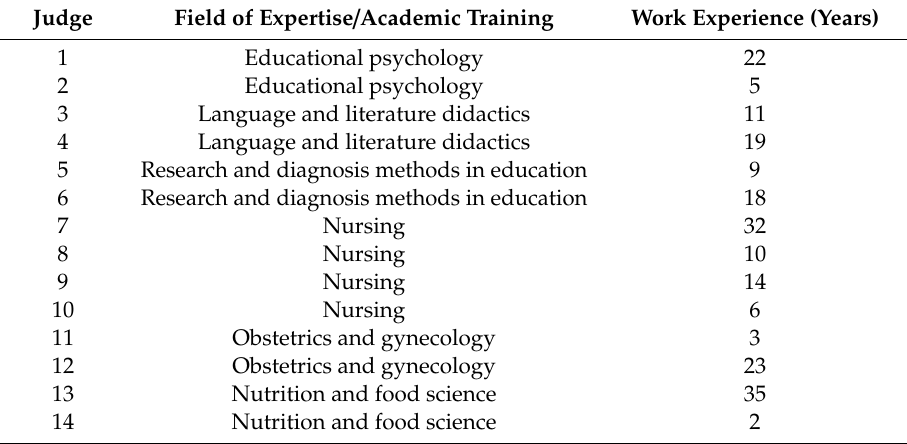
Table 1. Judges, field of expertise, academic training, and work experience.